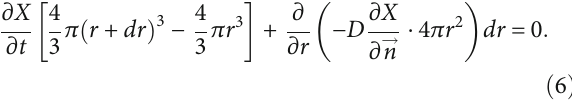
Figure 4: Node division under the spherical coordinate